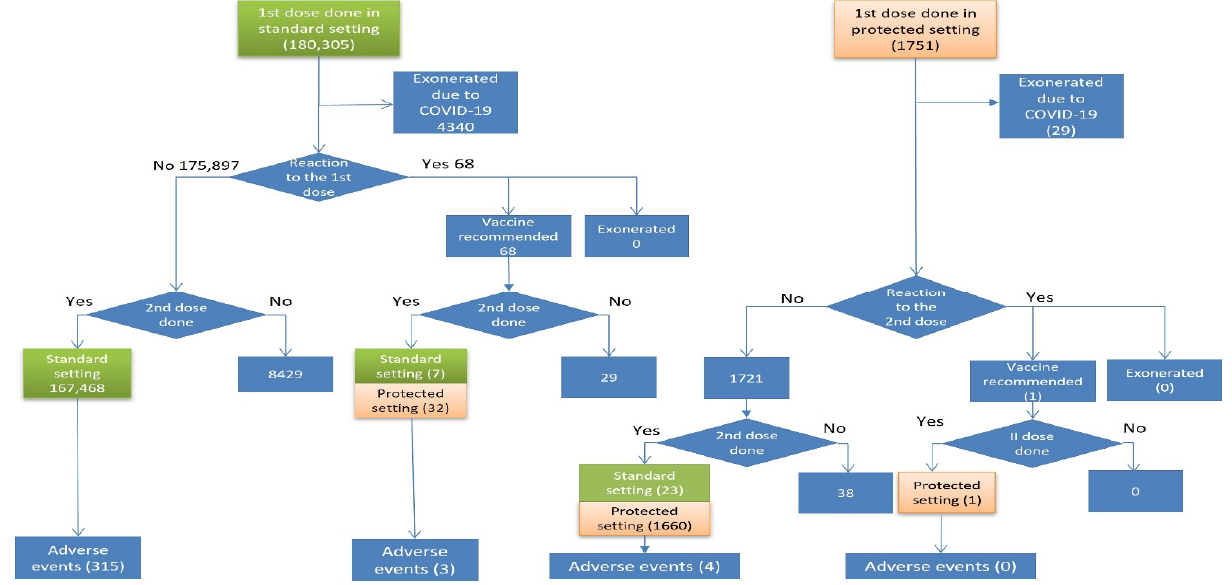
Figure 2. Flowchart of the second dose vaccinations, exonerations, and adverse events by risk pathway.